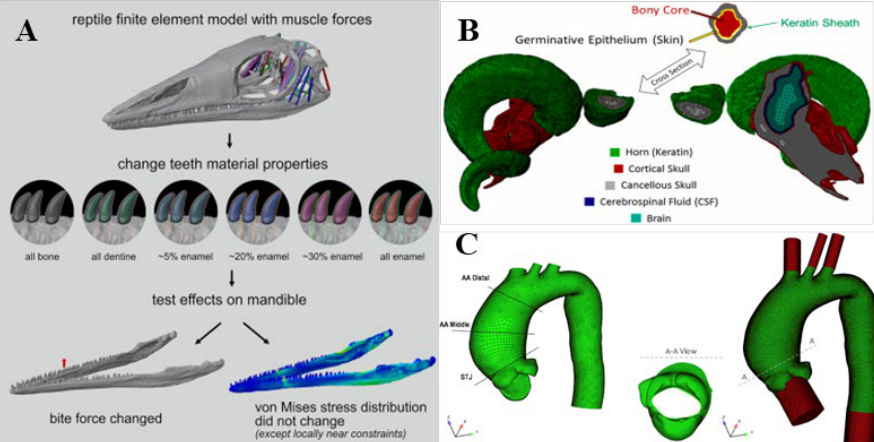
Figure 1. Application of FEA methods in the field of biomechanics. ( A ) tooth enamel models [28], ( B ) brain model during impact (Reprinted with permission from Ref. [29]. Copyright 2021, Elsevier), ( C ) ascending thoracic aortic aneurysms models (Reprinted with permission from Ref. [30]. Copyright 2018, Elsevier).